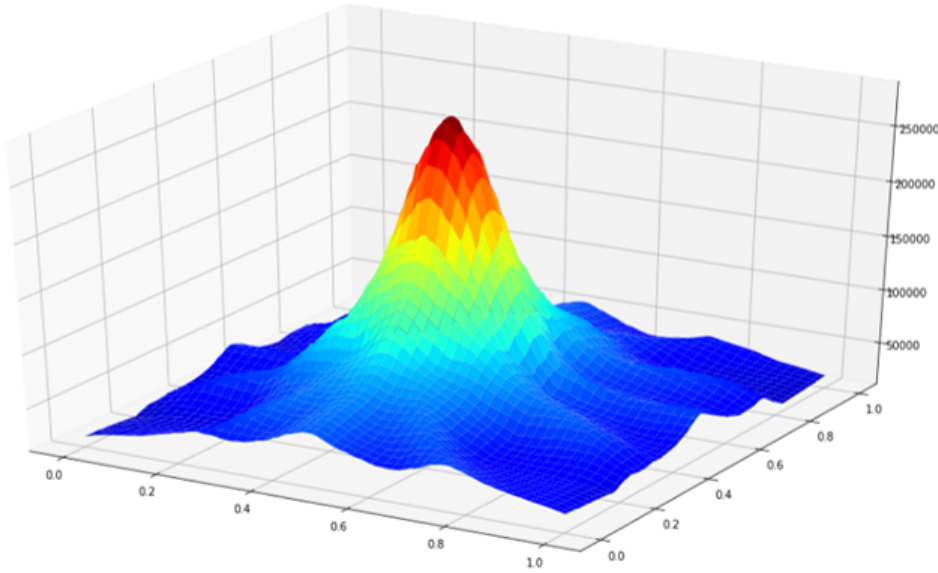
Figure 6. An example of the output image reconstructed from 1206 backscattered points collected using six antennas.